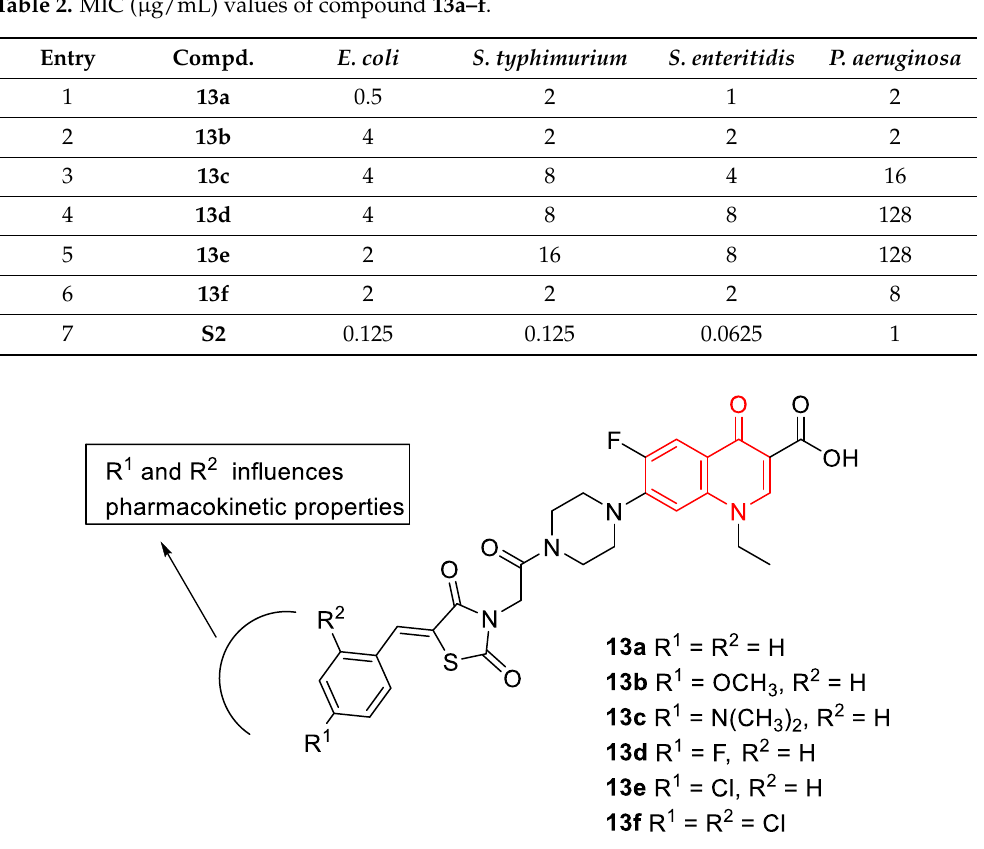
Table 2. MIC (µg/mL) values of compound 13a – f